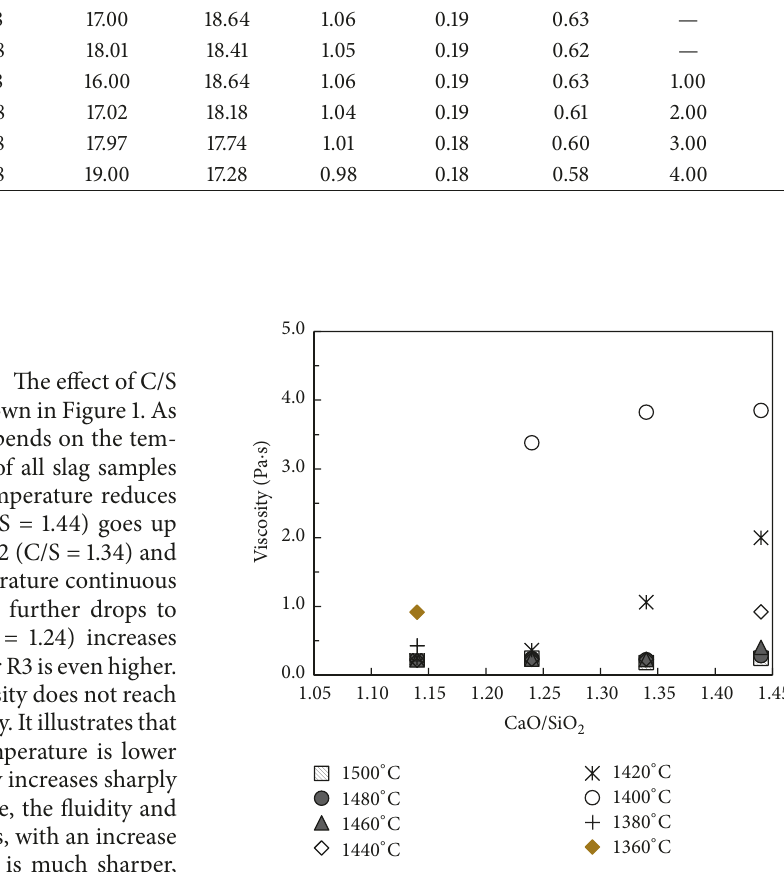
Figure 1: Viscosity isotherms for slag series R and basic slag.